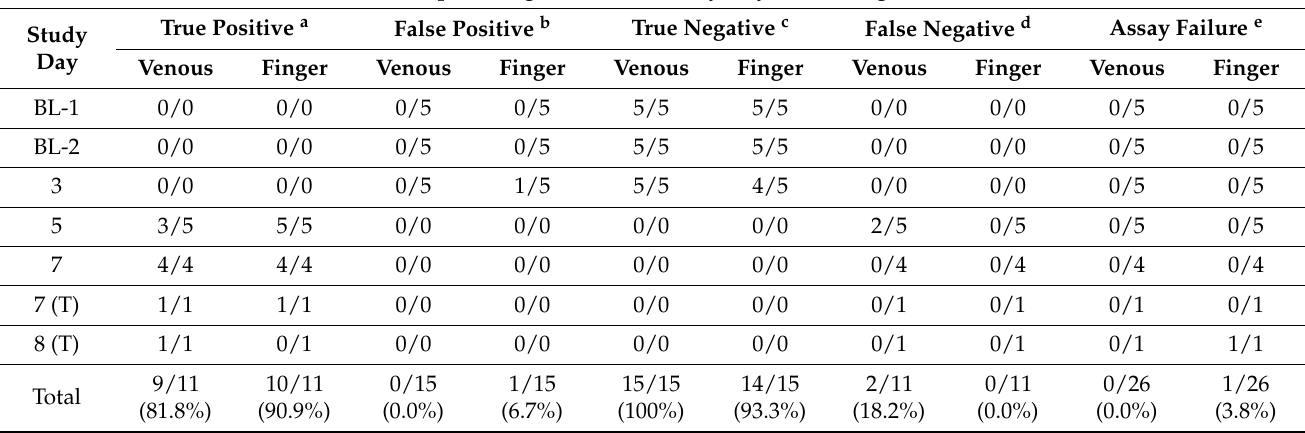
Table 4. Assay performance summary for the OraQuick ® assay using venous and fingerstick NHP blood compared to the EZ1 RT-PCR